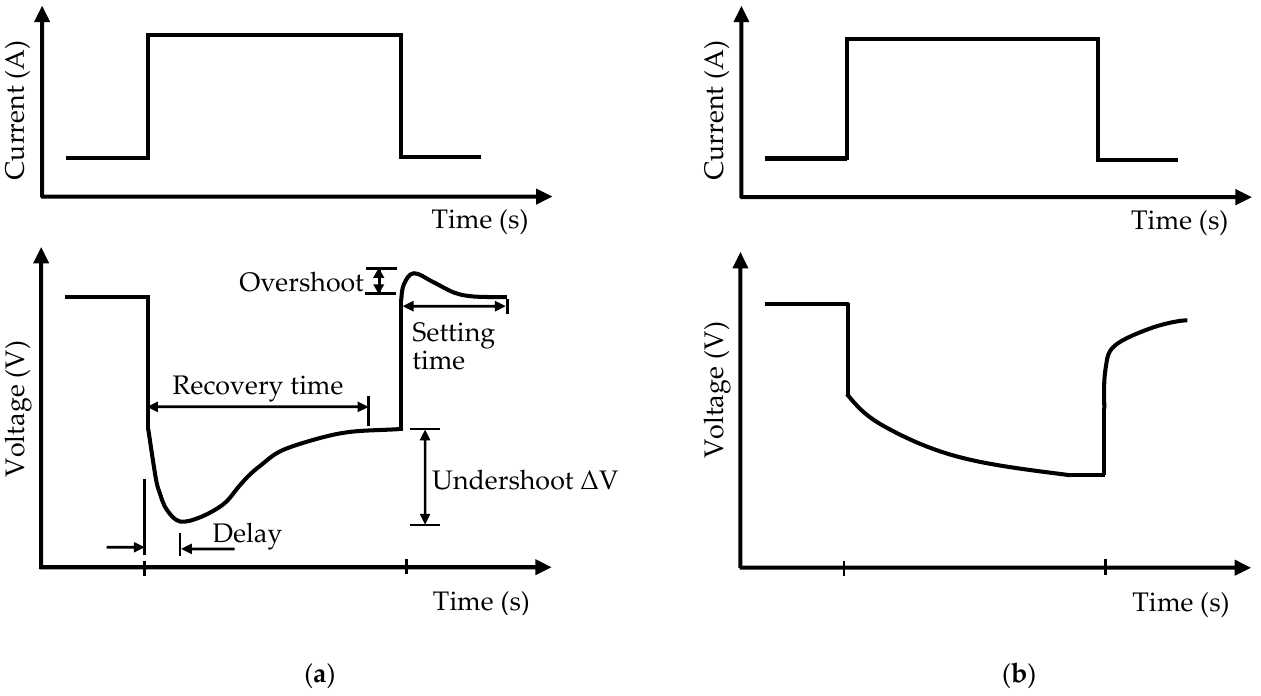
Figure 2. Typical fuel cell ( a ) and batteries’ ( b ) transient response.